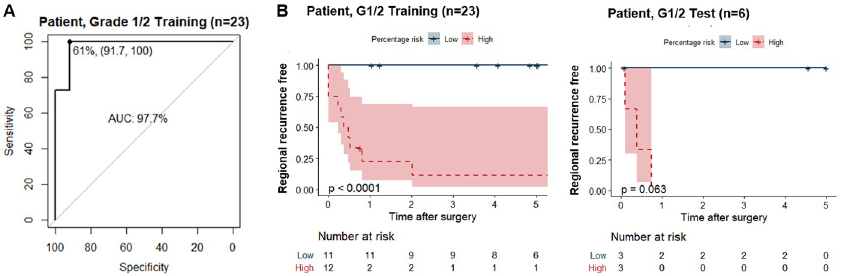
Using the same algorithm of the percentage of positive cells on G3 tumors, a cutoff of 25% achieved the best performance with 80.0% sensitivity, 100% specificity, and 83.3% accuracy.